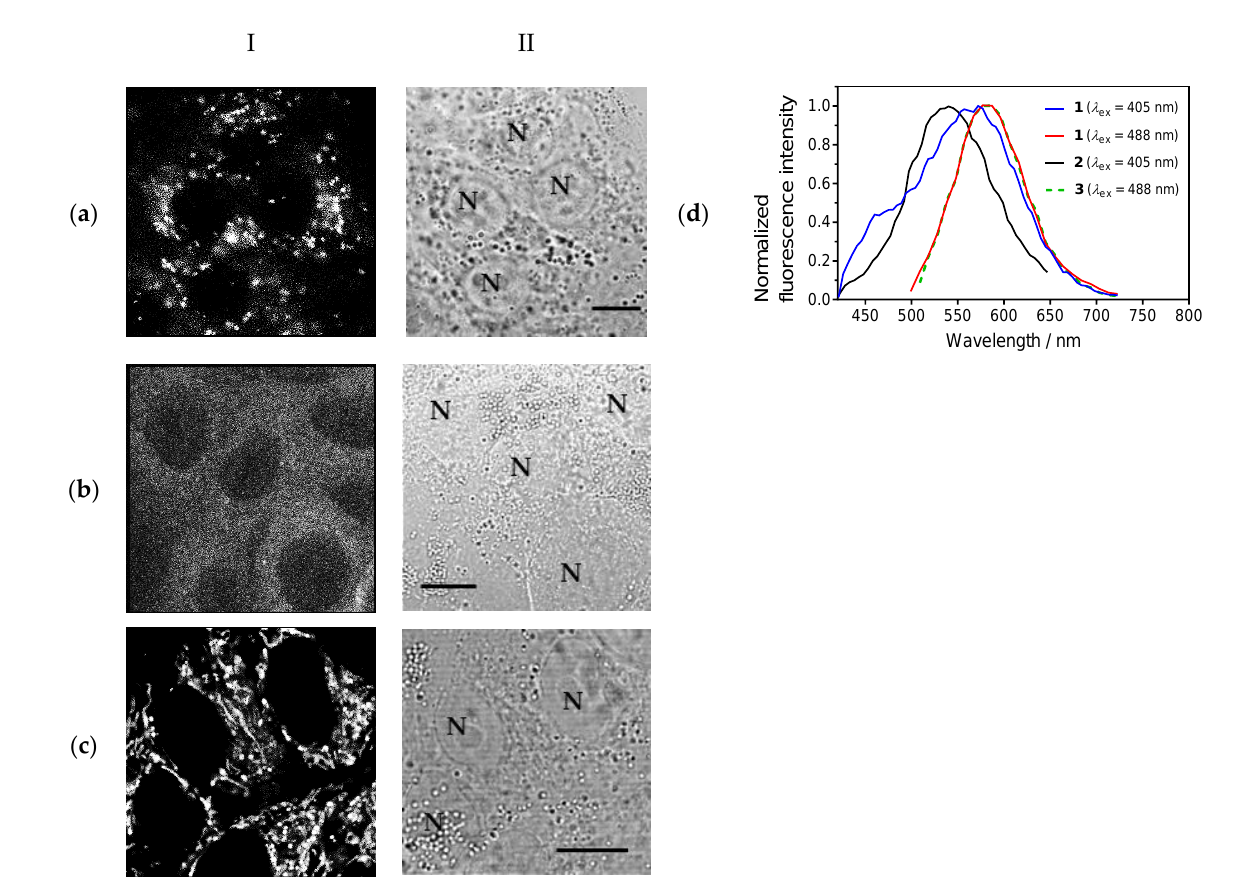
Figure 3. Confocal fluorescence images ( a – c ) and fluorescence spectra ( d ) of 1 – 3 in A549 cells. ( a – c ) Typical intracellular distributions (column I) of 1 ( a ), 2 ( b ), and 3 ( c ) and corresponding transmitted light images of cells (column II). Bar represents 10 μm. N marks a nucleus. Cells were incubated with 1 – 3 (10 μM) for 30 min. ( d ) Typical intracellular fluorescence spectra of 1 , 2 , and 3 normalized to the maximum. At λ ex = 488 nm, spectra of 1 and 3 coincide in a shape.